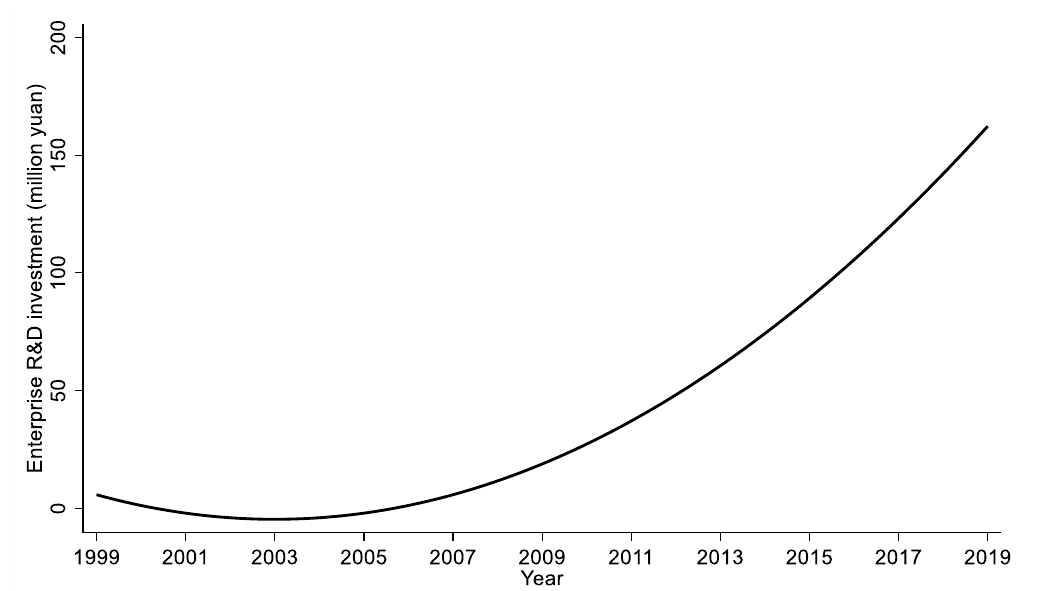
Figure 5. Change trend of R&D investment. (Source: Produced by the authors from the sample data using Stata 16.1).